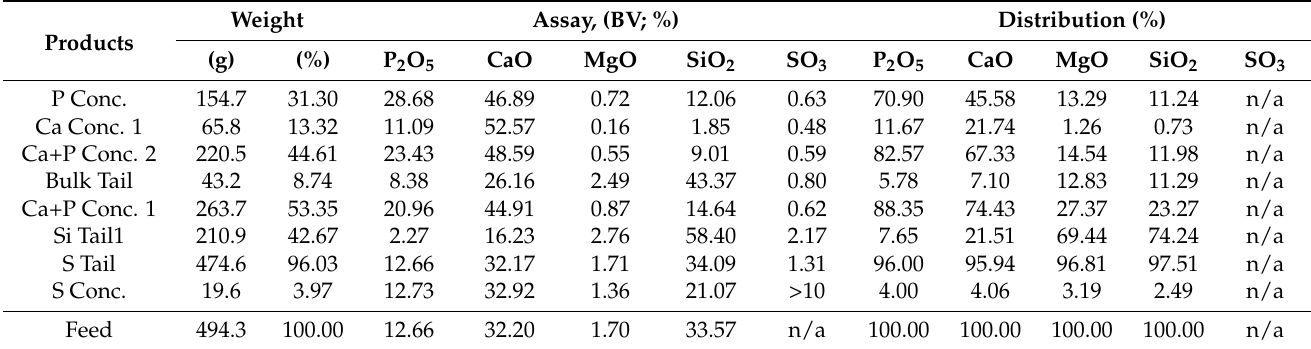
Table 8. Results of batch flotation test SP-9 on skarn